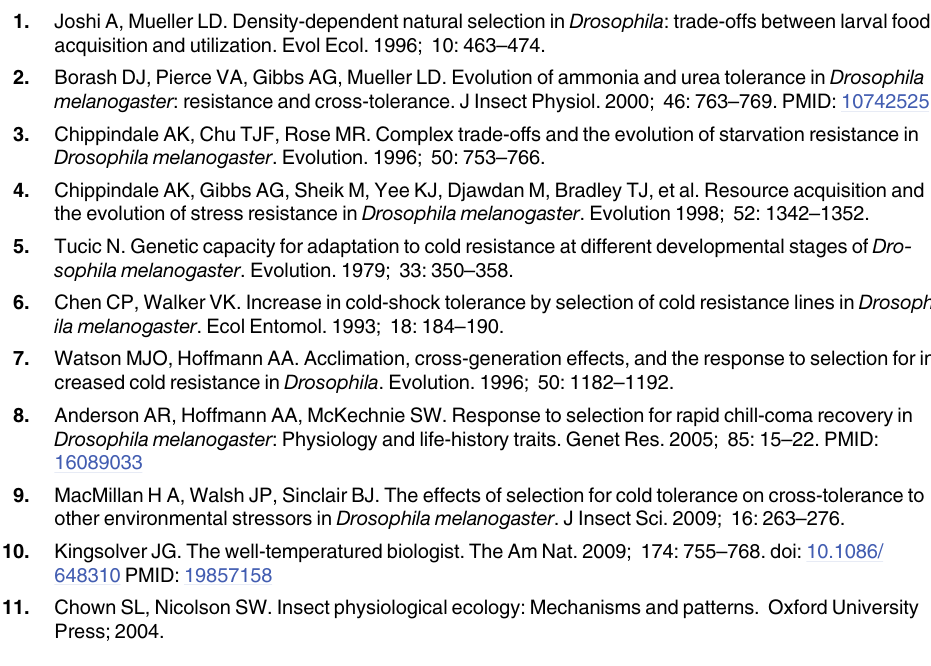
S3 Fig. Experimental design for the measurement of egg viability, fecundity and mating fre- quency post cold shock. On 12 th day post egg collection, both FSB (1 – 5) and FCB (1 – 5) flies were subjected to the treatments. Post treatment, flies were immediately transferred into cages and a fresh food plate was provided. This food plate was replaced with a new one six hours later. The eggs laid on the first food plate were counted and some of those eggs were used to es- timate hatchability. Thus we obtained fecundity and egg hatchability values for the 0 – 6 hours post treatment period. A fresh food plate was provided between 24 – 30 hours post treatment to measure fecundity and egg hatchability as before. In the Both-Shocked and Neither-shocked treatment, we also noted the number of mating pairs in each cage, every 30 minutes, for 36 hours post